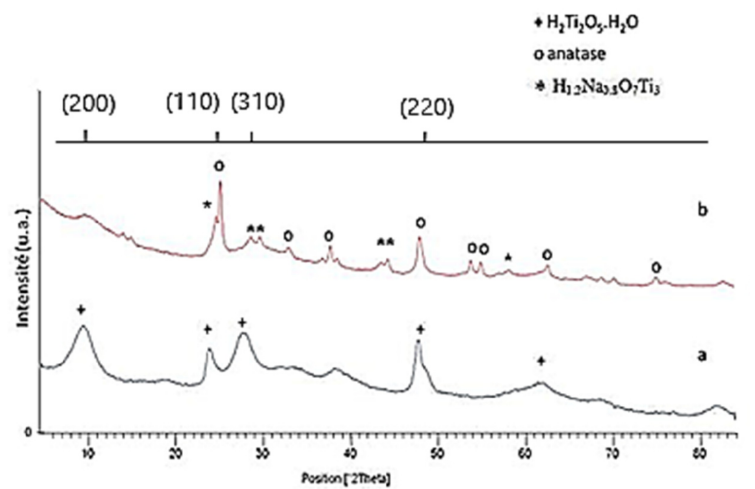
Figure 1. XRD of orthorhombic H 2 Ti 2 O 5 phase ( a ) and calcined TiO 2 nanotubes (TON) ( b